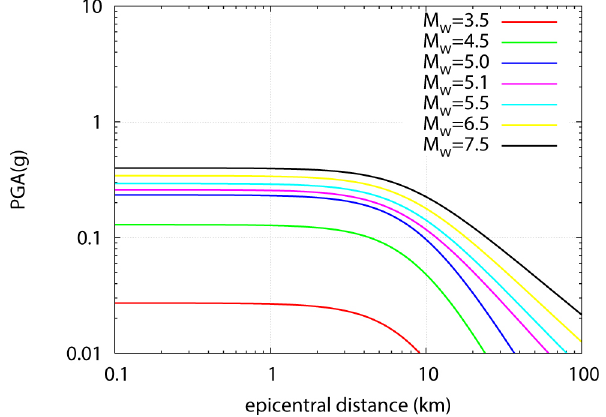
Figure 3. Attenuation of shallow earthquakes for stiff soil sites and 10km of epicentral distance. Magnitudes above 5 have been atten- uated with Ambraseys et al. (2005) and magnitudes equal or below 5 with Bragato and Slejko